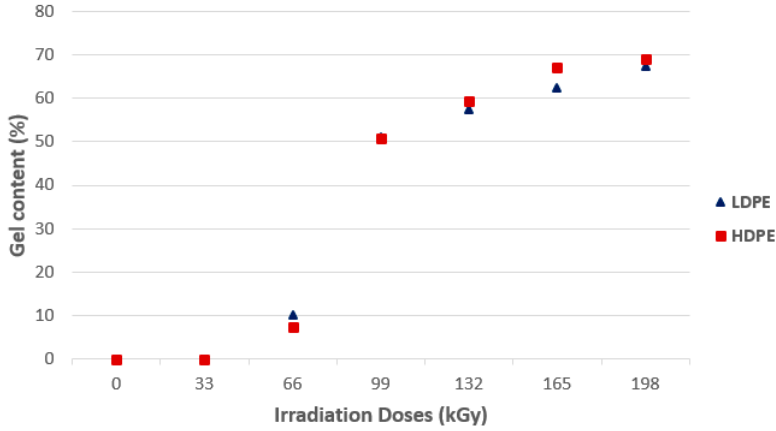
Figure 5. Gel content—Commodity polymers.